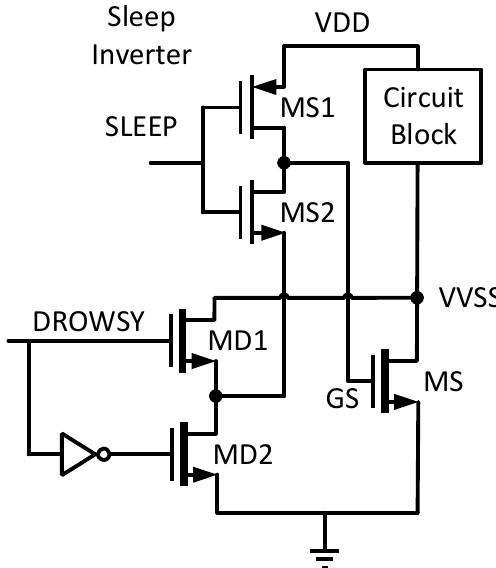
Figure 2. Implementation of sleep mode design.